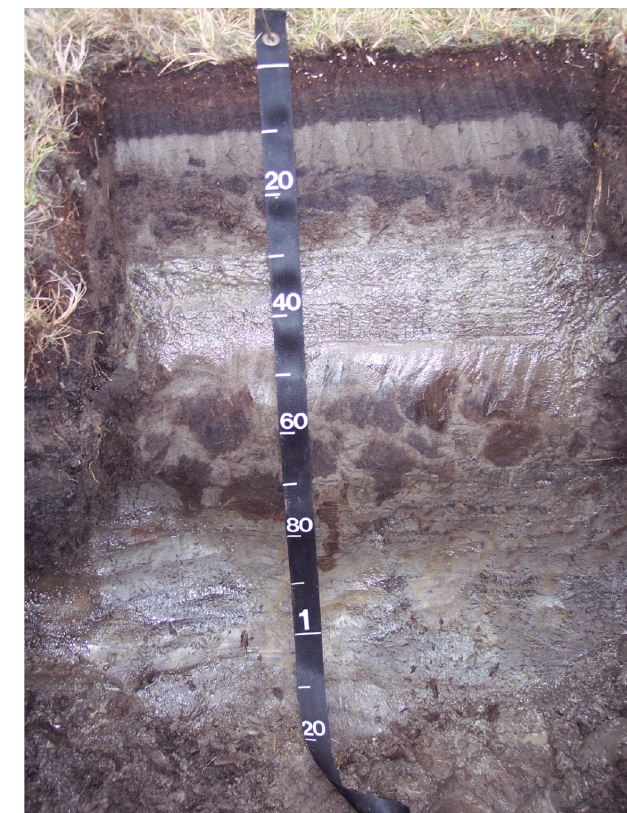
Figure 5. Gelisol profile from the Arctic coastal plain of northwest- ern Alaska exhibiting a complex stratigraphy developed through a sequence of different environments coupled with cryoturbation caused by freeze/thaw/heave forces. The strata suggest that (1) old coastal plain sediments below 80cm thawed and collapsed into a thaw lake as indicated by the mixed-up sediments with scattered fragmental peat chunks; (2) after drainage, an organic mat devel- oped at 50 to 80cm; (3) this mat was flooded or collapsed within the lake basin and was covered by limnic silts at 30–50cm; (4) after a second drainage, another organic mat covered the limnic silts at 15 to 30cm; (5) windblown eolian silt covered this mat at 10–16cm; and (6) a final organic mat developed at the surface. The fluctuating and rising permafrost table disrupted the underlying organic